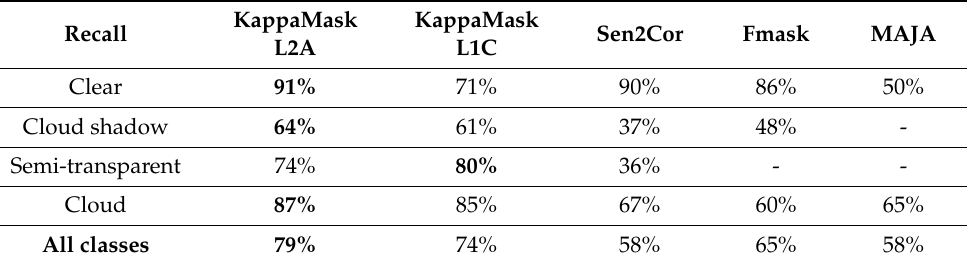
Table 4. Recall evaluation performed on the test dataset for KappaMask Level-2A, KappaMask Level-1C, Sen2Cor, Fmask and MAJA cloud classification maps. Evaluation is performed for clear, cloud shadow, semi-transparent and cloud classes.